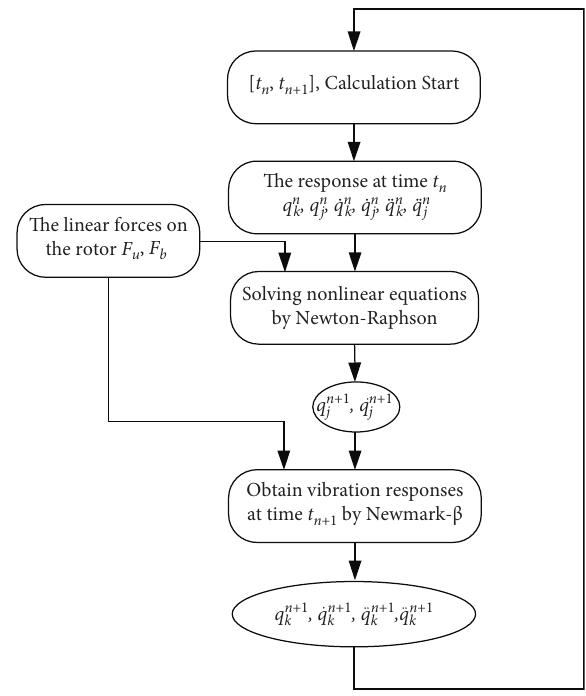
Figure 6: Flow chart of the implicit newmark- β